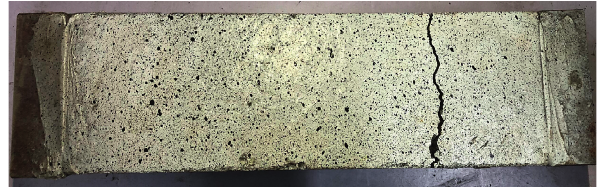
Figure 6: Crack patterns of RSCC-5% test